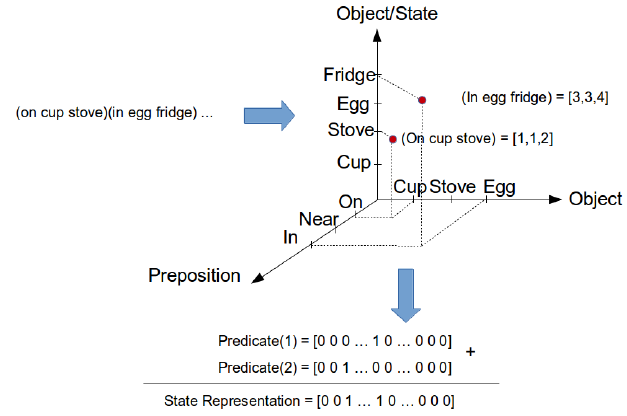
Figure 9: Converting symbolic representation to a binary